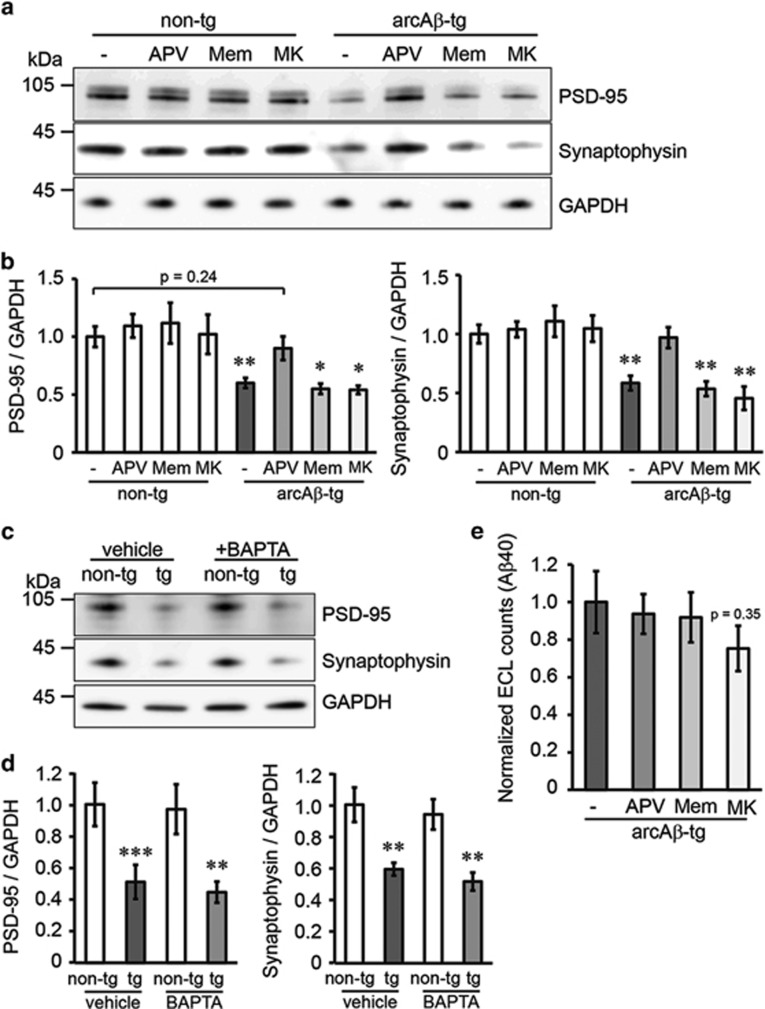
Blocking glutamate binding to NMDARs but not Ca2+ influx prevents the loss of pre- and postsynaptic markers in arcAβ-transgenic cultures. (a) Representative western blot of cell lysates from non-transgenic or arcAβ-transgenic cultures after treatment with NMDAR antagonists APV (100 μM), memantine (1 μM) or MK-801 (30 μM). (b) Quantification of western blots. PSD-95 and synaptophysin levels are strongly reduced in arcAβ-transgenic cultures. APV treatment restores PSD-95 and synaptophysin signals back to control levels, whereas memantine and MK-801 have no effect. n=6. (c) Representative western blot of cell lysates from non-transgenic or arcAβ-transgenic slices after treatment with Ca2+ chelator BAPTA (2 mM) or vehicle (BAPTA solvent NaHCO3). (d) BAPTA treatment does not affect loss of synaptic proteins in transgenic cultures. n=6. (e) Aβ40 levels in the supernatant of arcAβ-transgenic cultures after treatment with NMDAR antagonists measured by MSD. Aβ40 production is not influenced by any NMDAR antagonist. Aβ levels were corrected by protein levels from lysates. n=3. All values are shown as mean±S.E.M. (*P<0.05, **P<0.01, ***P<0.001; two-tailed unpaired Student's t-test; significances indicate differences to the respective non-transgenic control). non-tg, non-transgenic; tg, arcAβ-transgenic; Mem, memantine; MK, MK-801